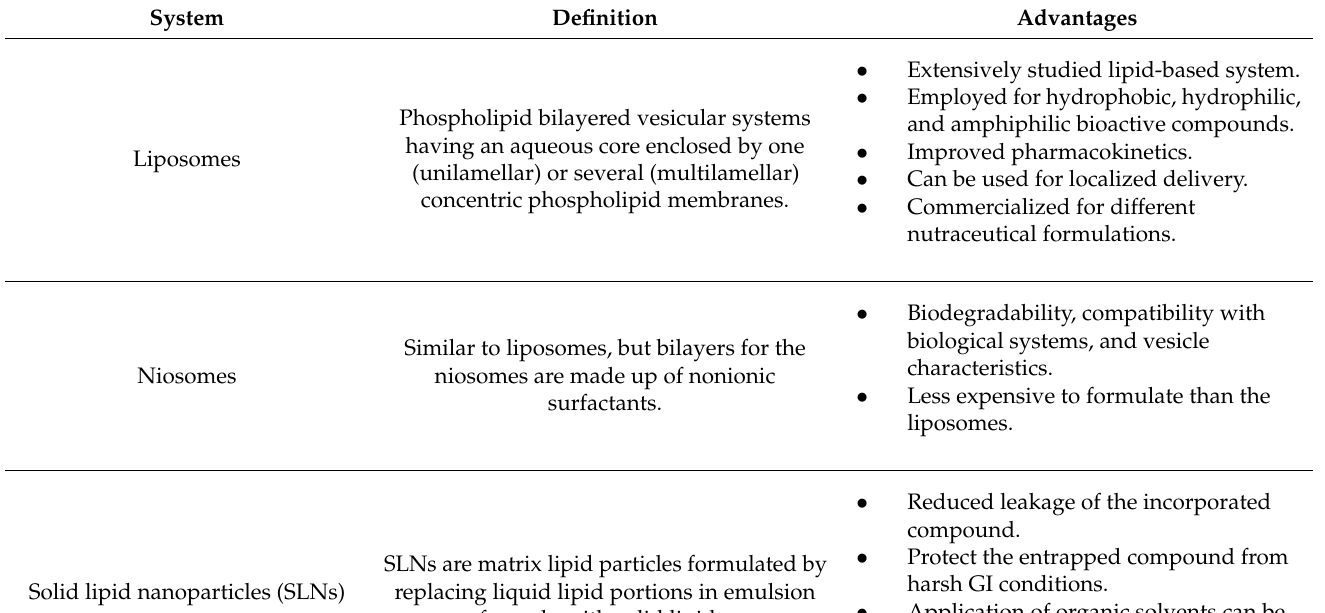
Table 1. Summary of the lipid-based delivery